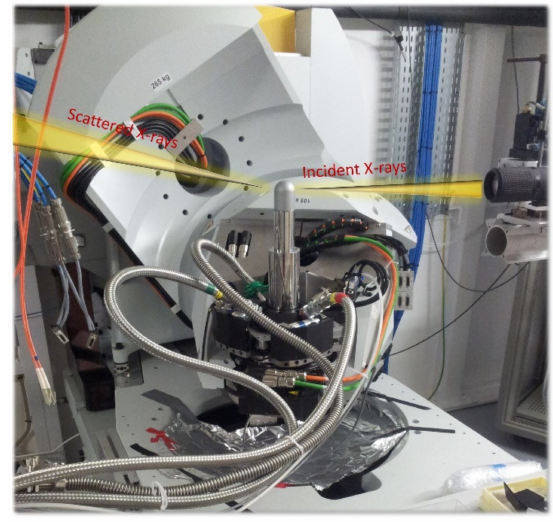
Figure 7. The D2AM cryostat mounted on the beamline kappa